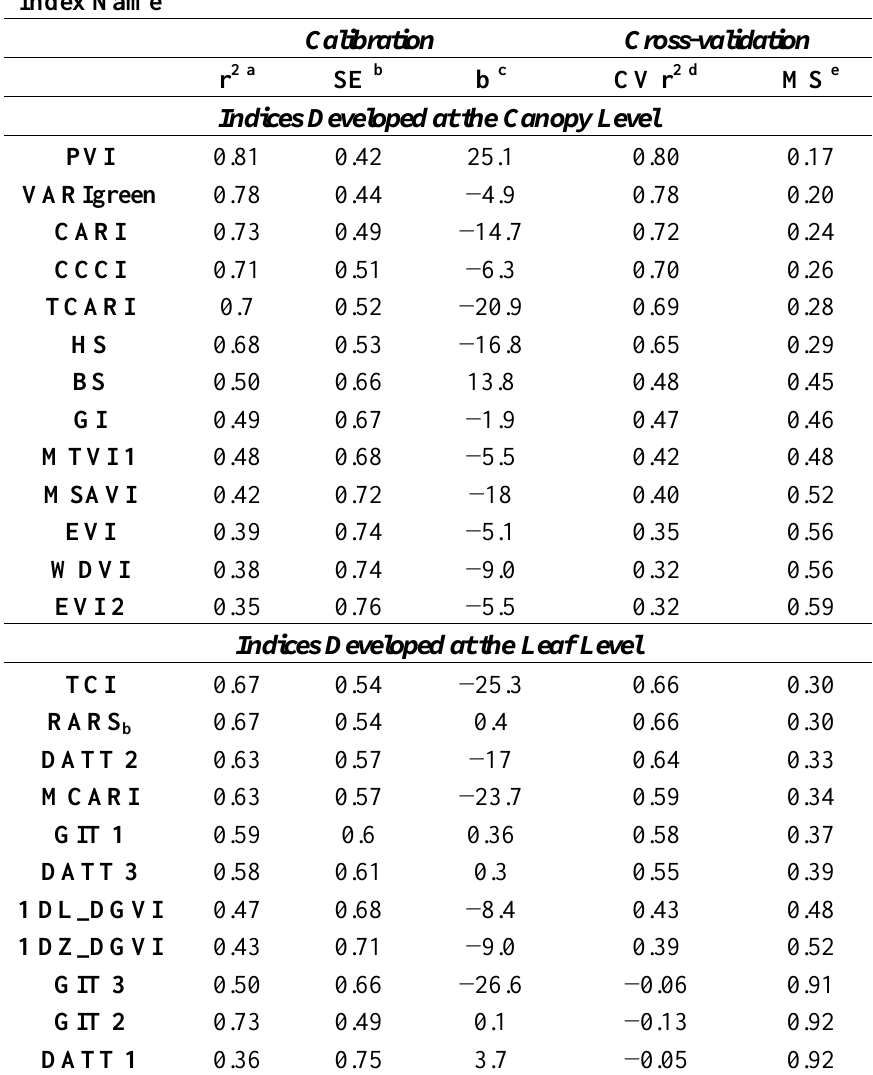
Table 4. Calibration and validation of the estimation of plant N concentration (%) by vegetation indices for the pooled Australian and Italian site (AUS + ITA) at Z30. Regressions were significant at p < 0.001. Indices are ordered by the coefficient of determination of the cross-validation (CV r 2